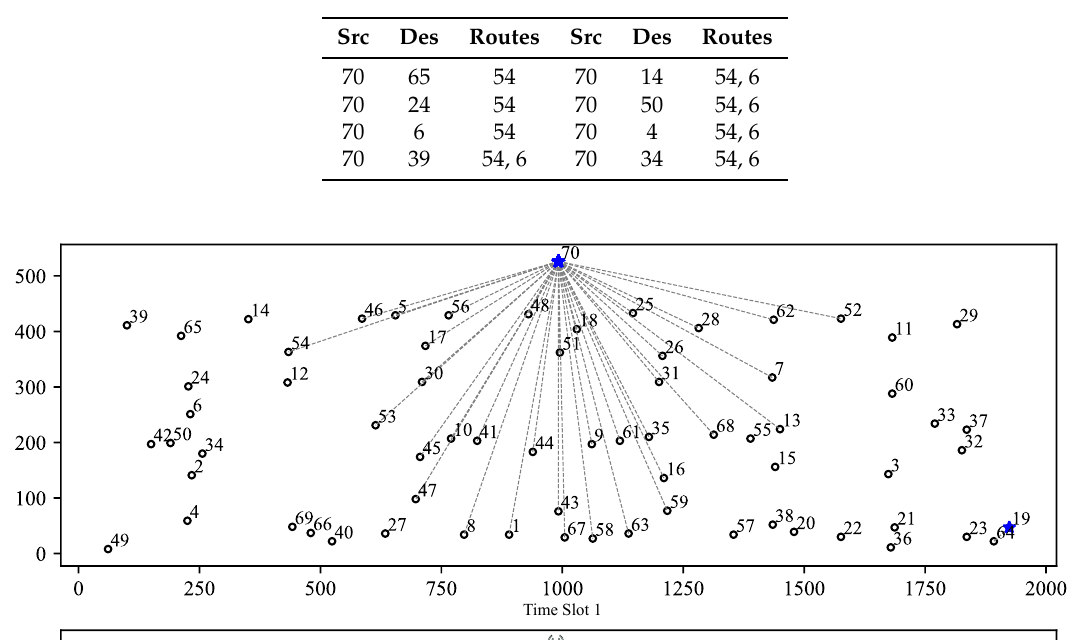
Table 6. Proportions of Different Hops in Routes of V (cid:42)(cid:41) V .